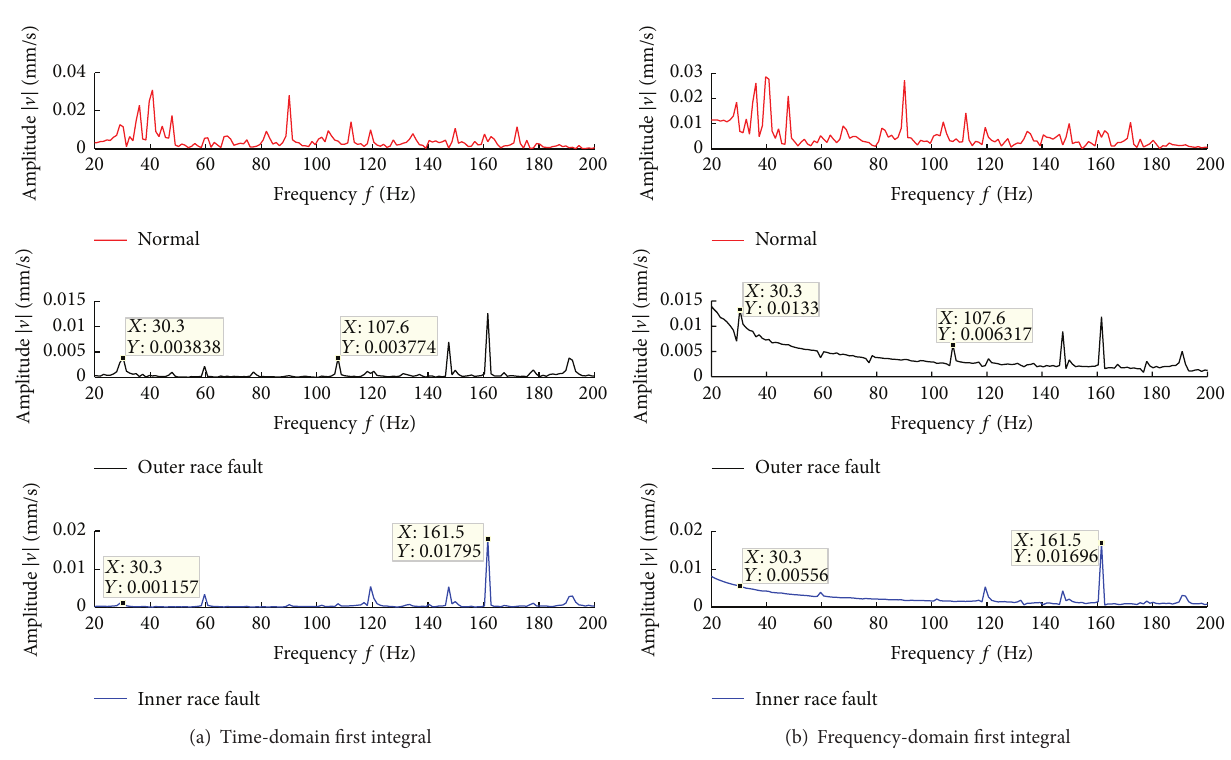
Figure 9: Amplitude spectra of the velocity signals acquired by traditional